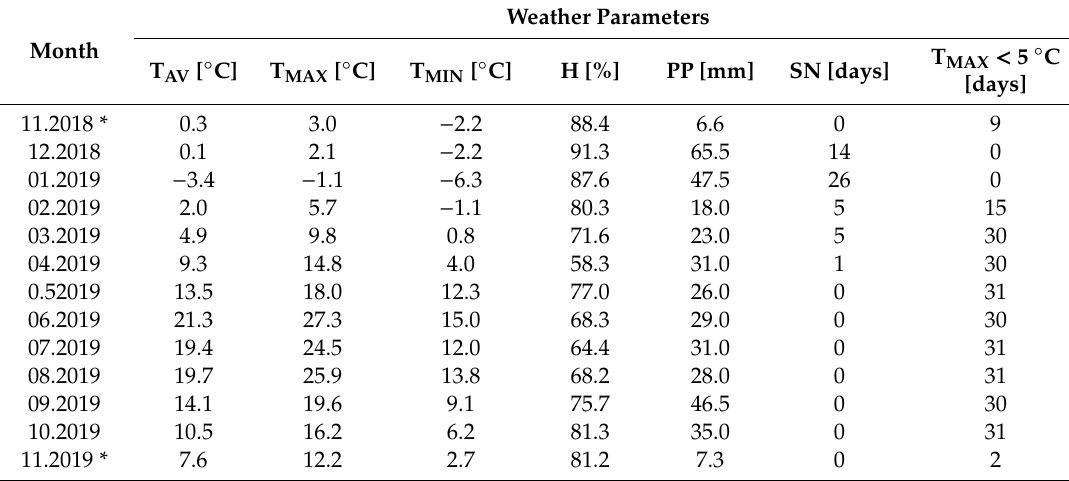
Table 2. Weather conditions recorded by Lublin station during the study on the survivability of Dermacentor reticulatus ticks; data from the Institute of Meteorology and Water Management [30].